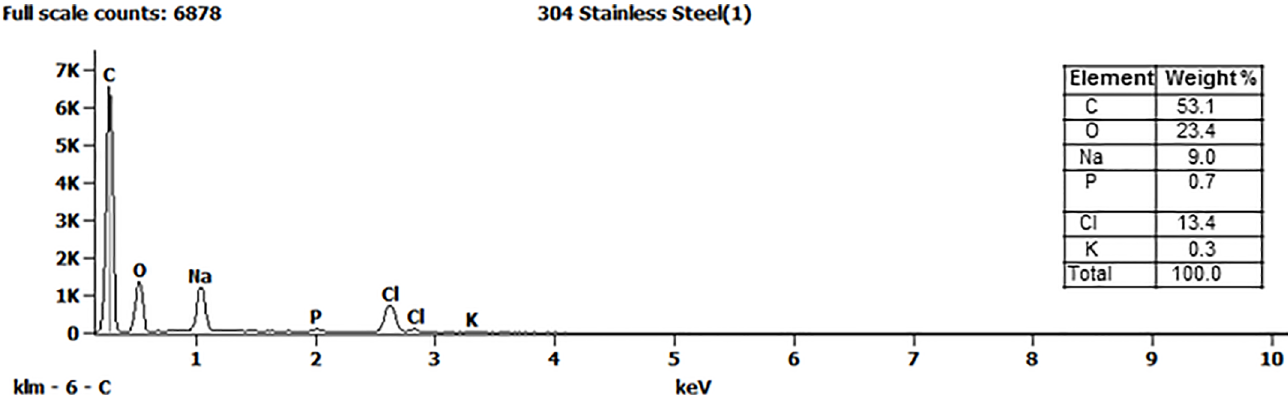
Fig 3. Energy dispersive X-ray spectroscopy: elementsin the residue on an AISI Type 304 carrierafter efficacytesting with the QCT-2 method.